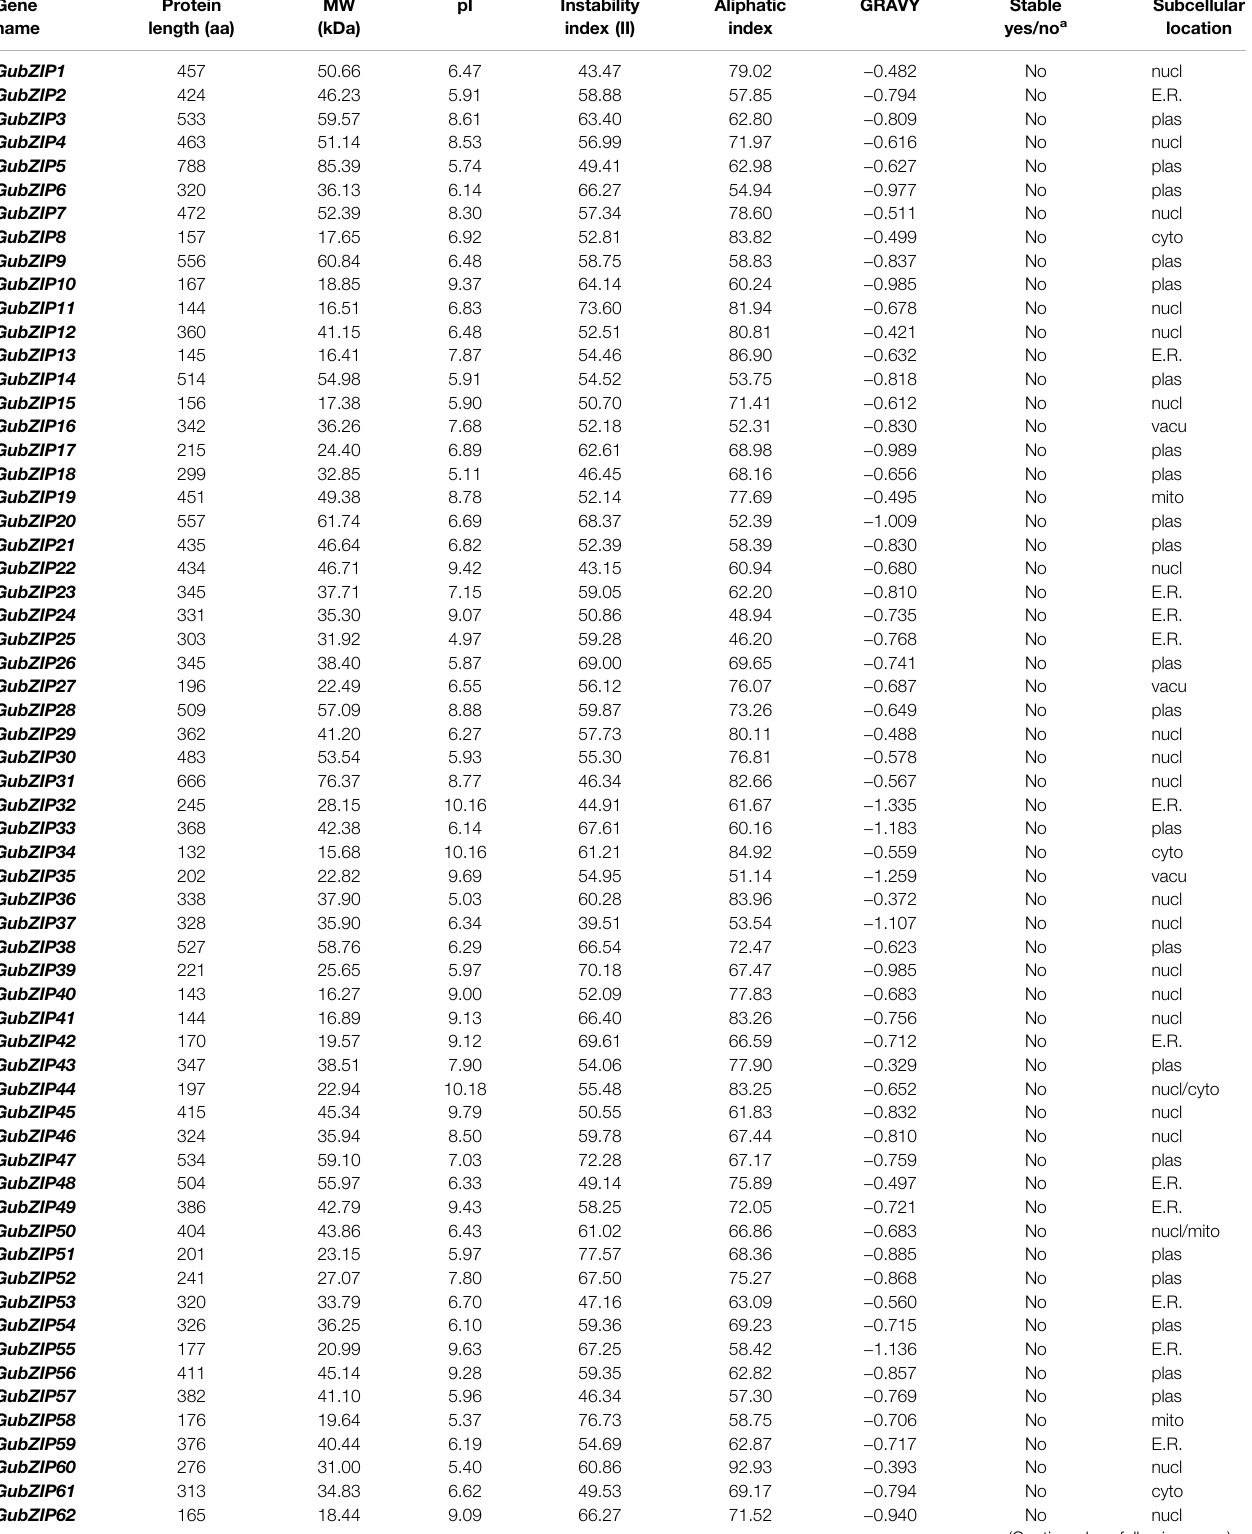
TABLE 1 | The detailed characteristics of bZIPs identi fi ed in Glycyrrhiza